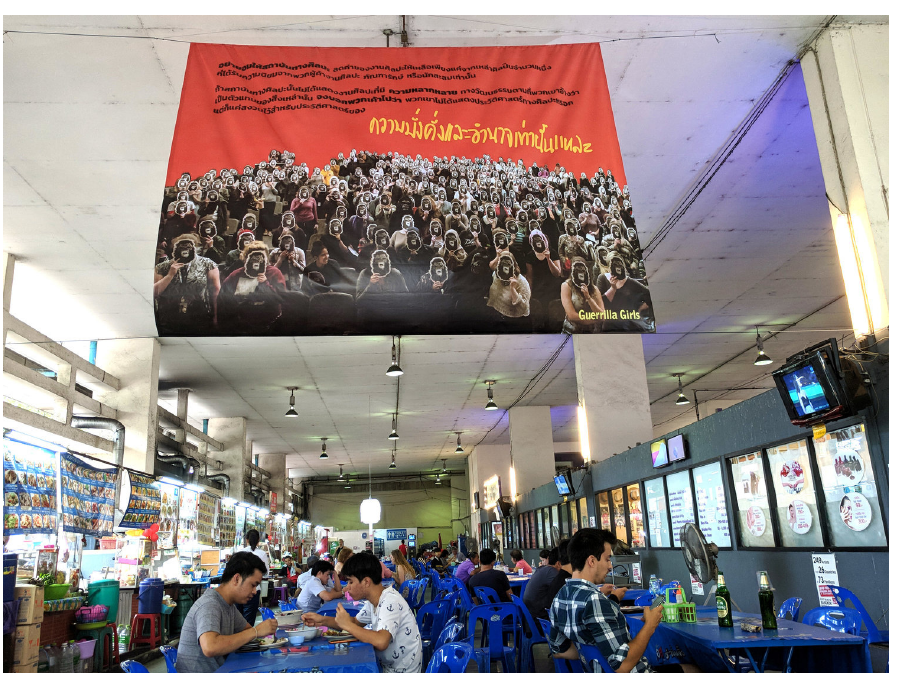
Figure 9. Wealth and Power by the Guerrilla Girls hanging in the food court at Bangrak Bazaar market (September 2018). Photo courtesy of LIV_ID.